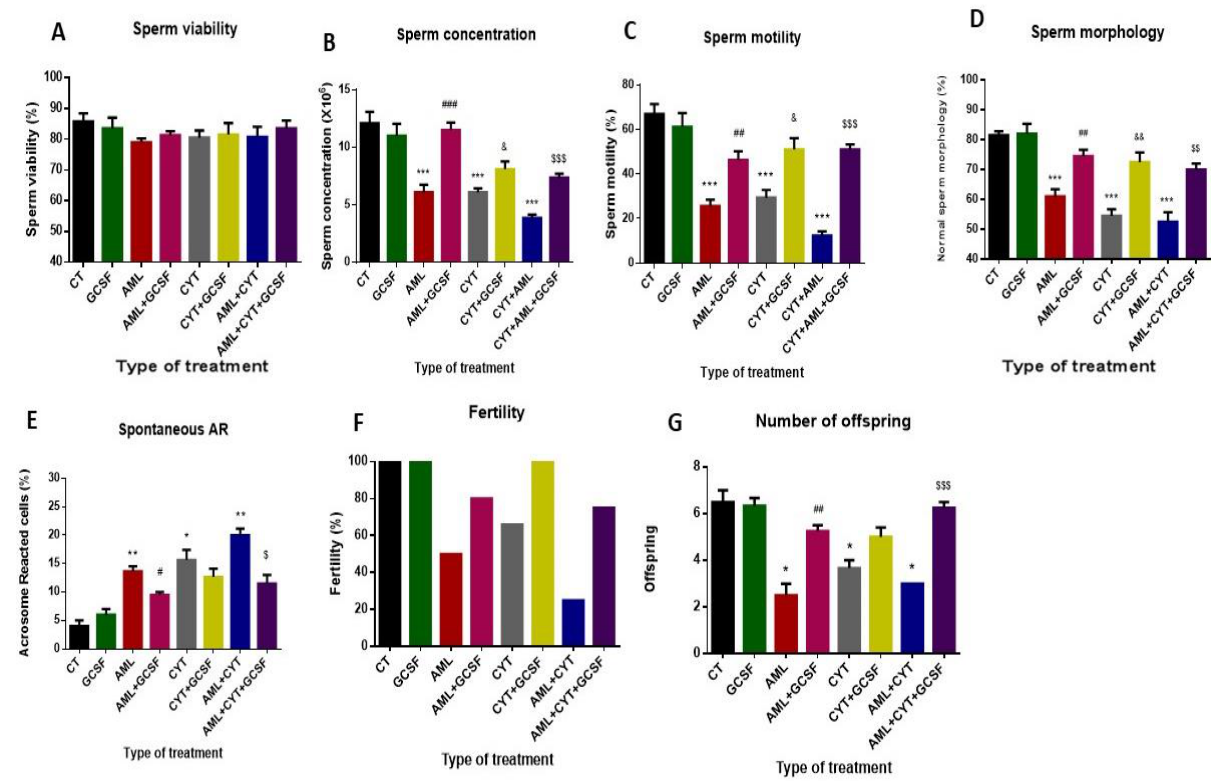
Figure 3. Effect of GCSF on sperm parameters, fertility capacity and number of offspring in AML- and CYT-treated groups. Mice were treated as described in Figure 2. Sperm were extracted from the epididymis 3 weeks post-treatment. Sperm concentration ( A ) was evaluated using a Makler counting chamber and determined according to WHO criteria. Sperm motility/immotility was evaluated using a Makler counting chamber and determined as a percentage of total sperm according to WHO criteria ( B ). Sperm morphology was evaluated following staining with Diff-Quick stain as described previously [18]. Cells were divided into normal and abnormal morphology, which includes: abnormal neck, abnormal tail, abnormal head according to WHO criteria. The percentage of sperm with normal morphology was calculated ( C ). Spontaneous AR was evaluated as described previously [21]. Sperm that were extracted from the epididymis were stained by fluorescein (FITC) staining. Acrosome reacted (without green staining) and non-reacted sperm (with green staining) were counted, and the percent of sperm that underwent spontaneous acrosome reaction was calculated ( D ). Viability of sperm cells was evaluated by their staining with 1% Eosin staining. Dead cells were stained in red color. The percent of live sperm cells was calculated ( E ). To examine the fertility capacity and offspring, two weeks post-treatment, a single male from each group was mated with two females. After two weeks, the females were separated, each to a single cage. The percentage of pregnant females ( F ) and the number of offspring from each female were counted after five weeks ( G ). The results are representative of three independent experiments with 5 mice in each group per experiment. *—significant compared to control (CT). #—significant compared to AML, &—significant compared to CYT, $—significant compared to AML + CYT.